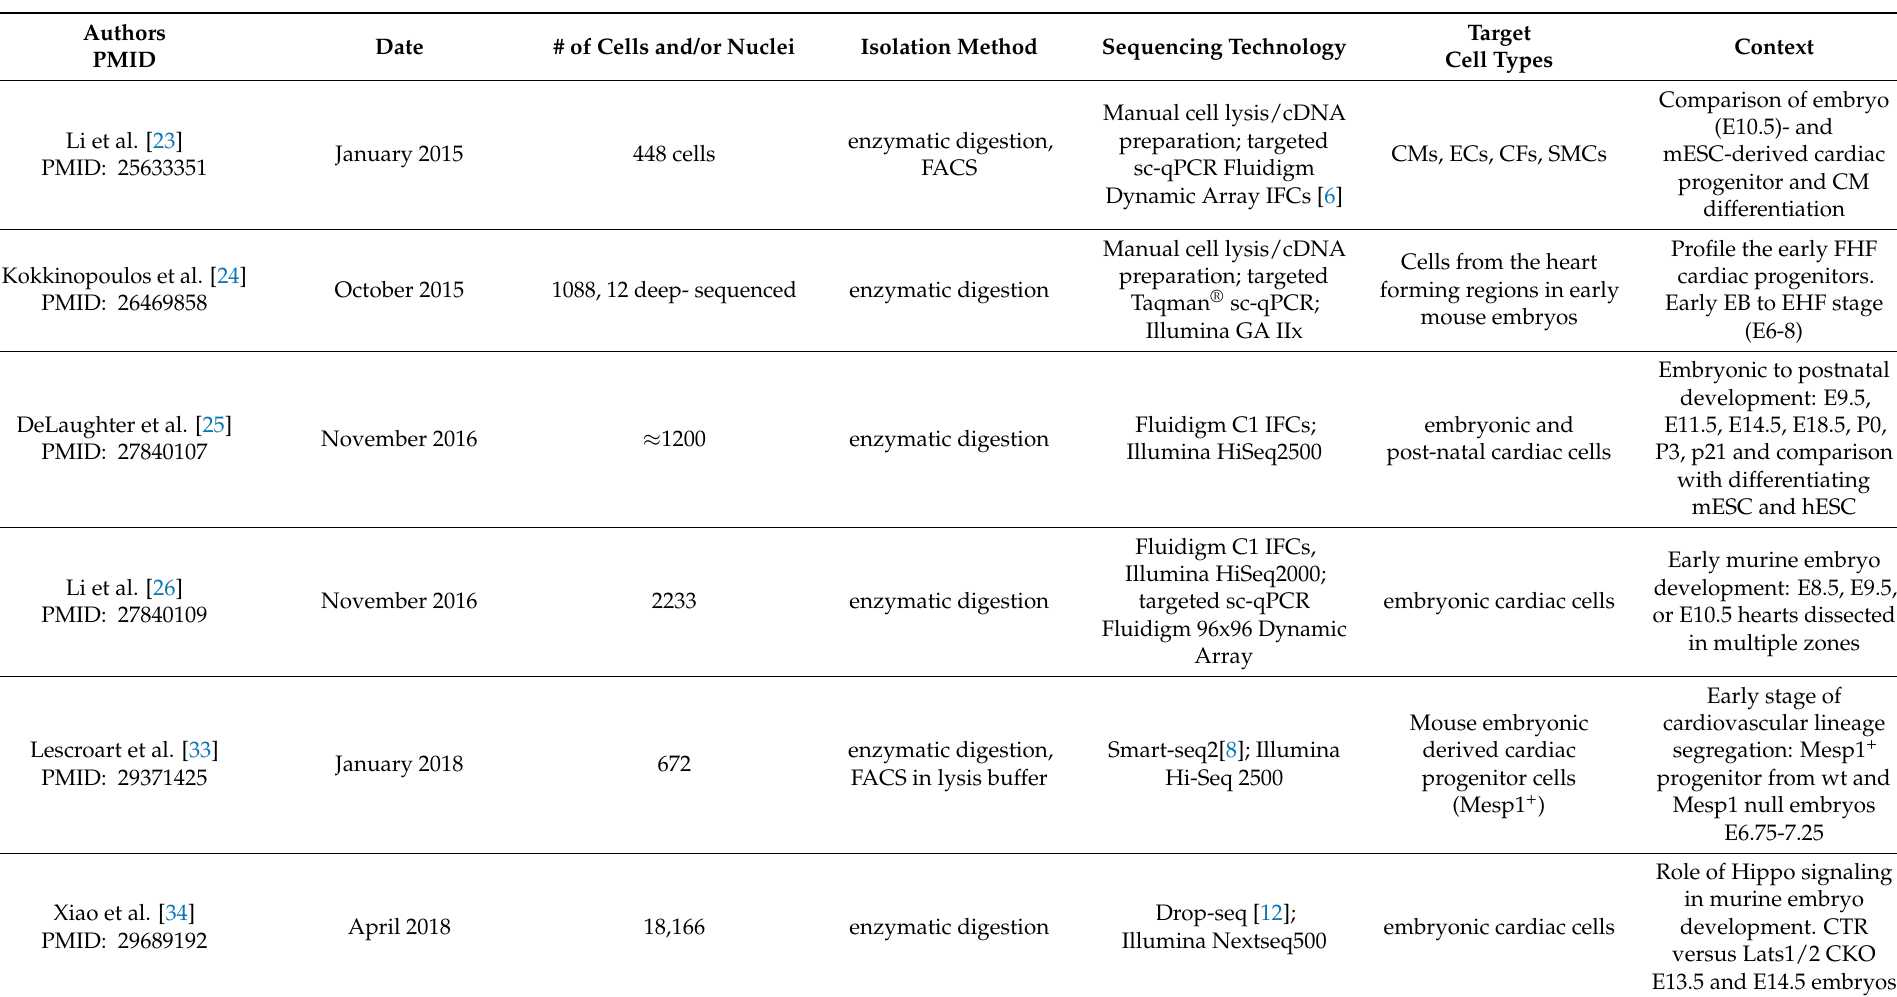
Table 1. Cardiac Development in Physiology and